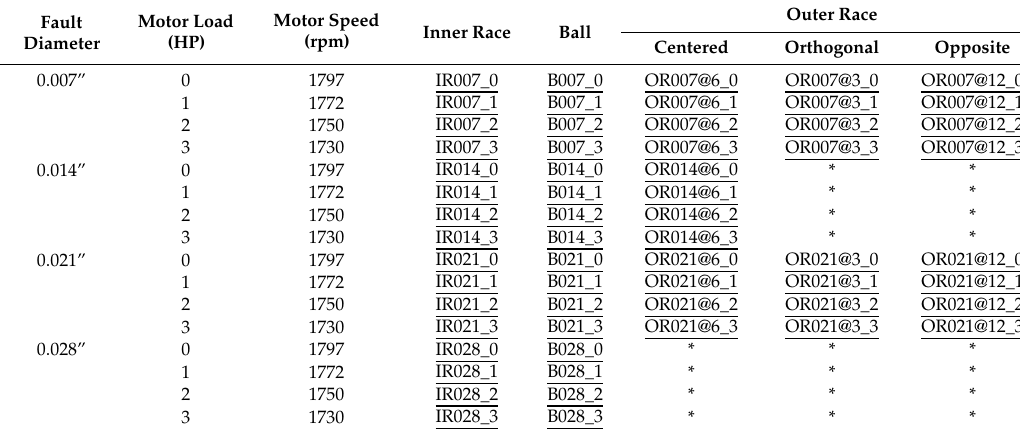
Table 2. CWR learning datasets (collected data at 12,000 samples / second) [45]. * data is not available in the database.